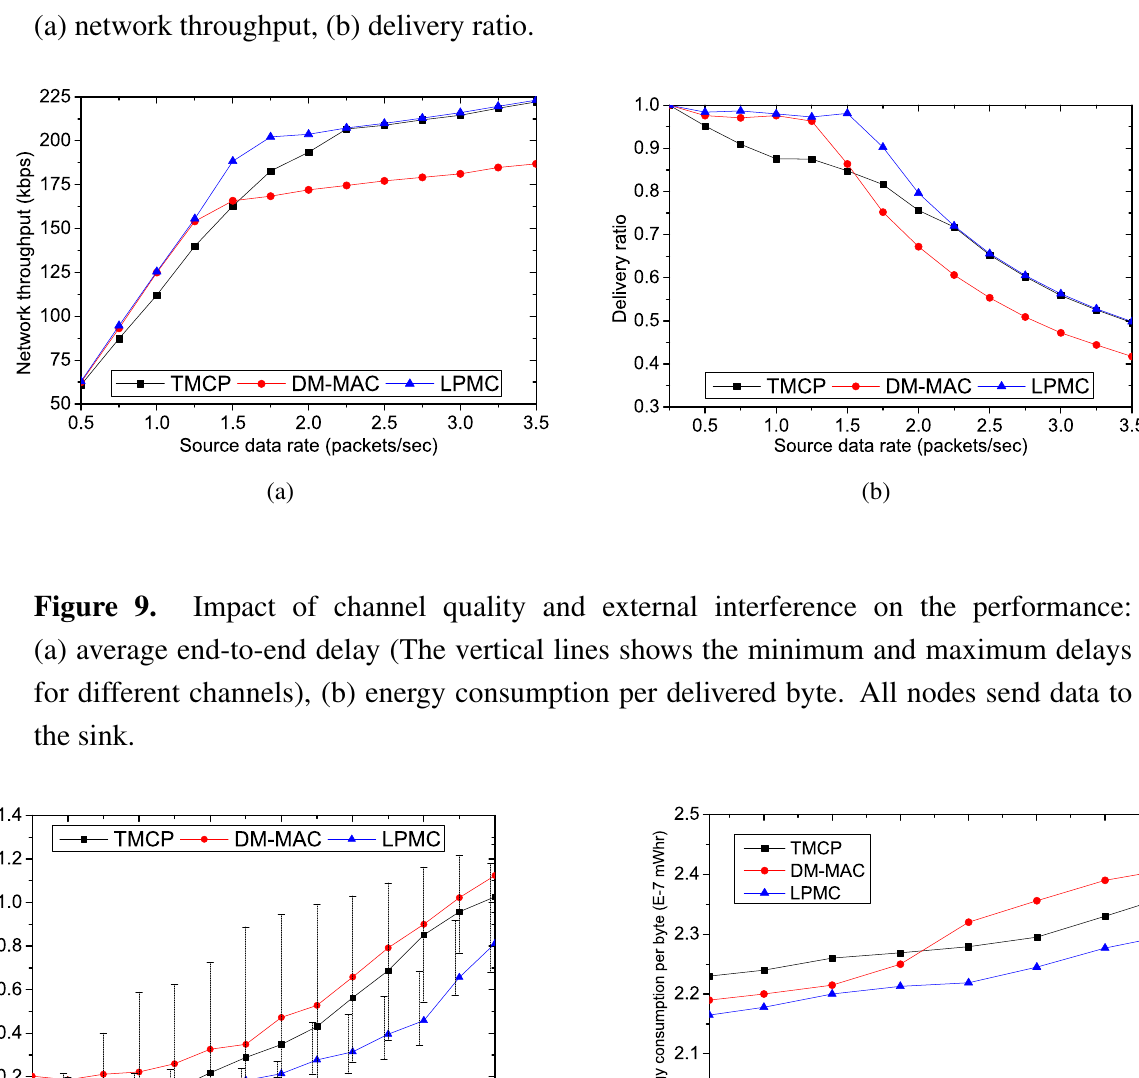
Figure 8. Impact of channel quality and external interference on the performance: (a) network throughput, (b) delivery ratio.